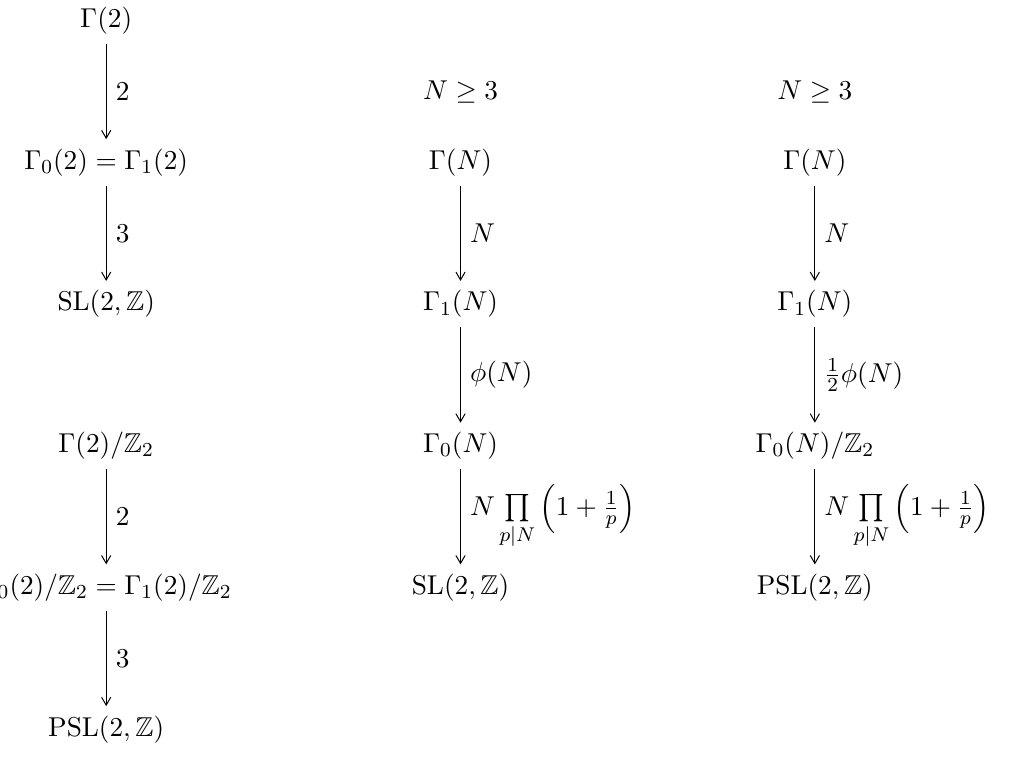
Figure 12 . Some congruence subgroups of level N with the indices of the group inclusions. On the right are congruence subgroups of PSL(2 ; Z ) of level N